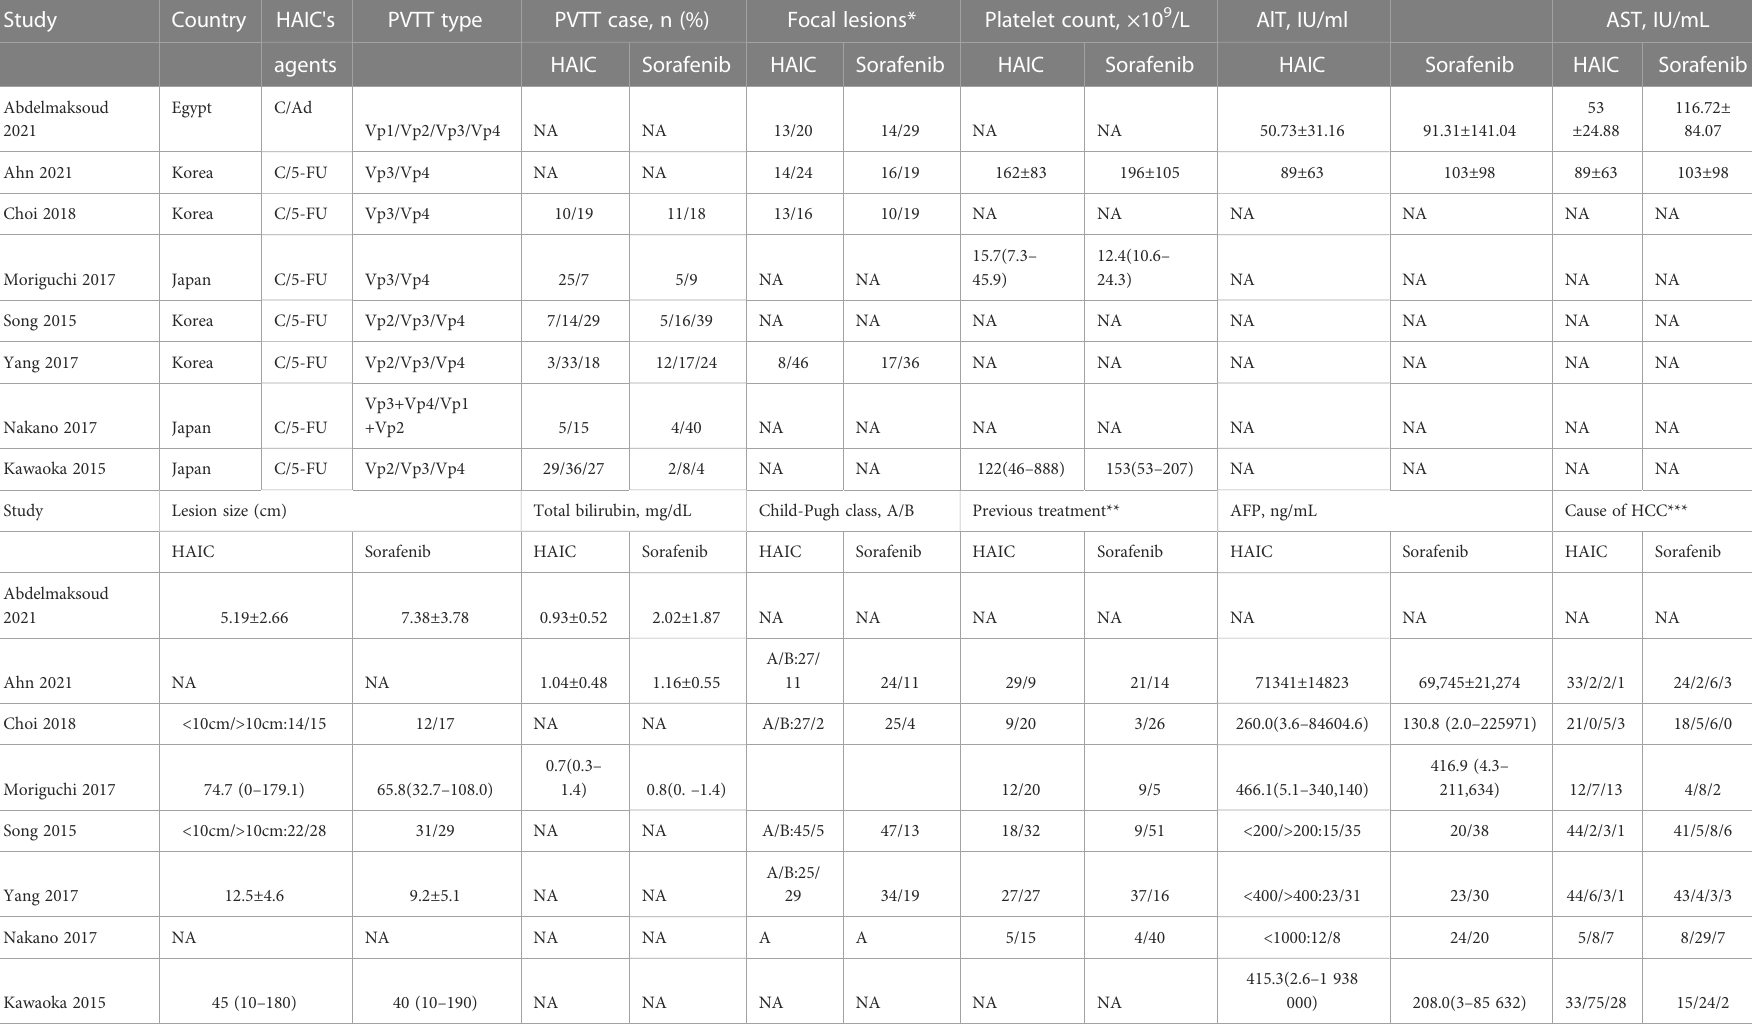
TABLE 2 Clinical characteristics and clinical outcomes of the two groups included in the study.